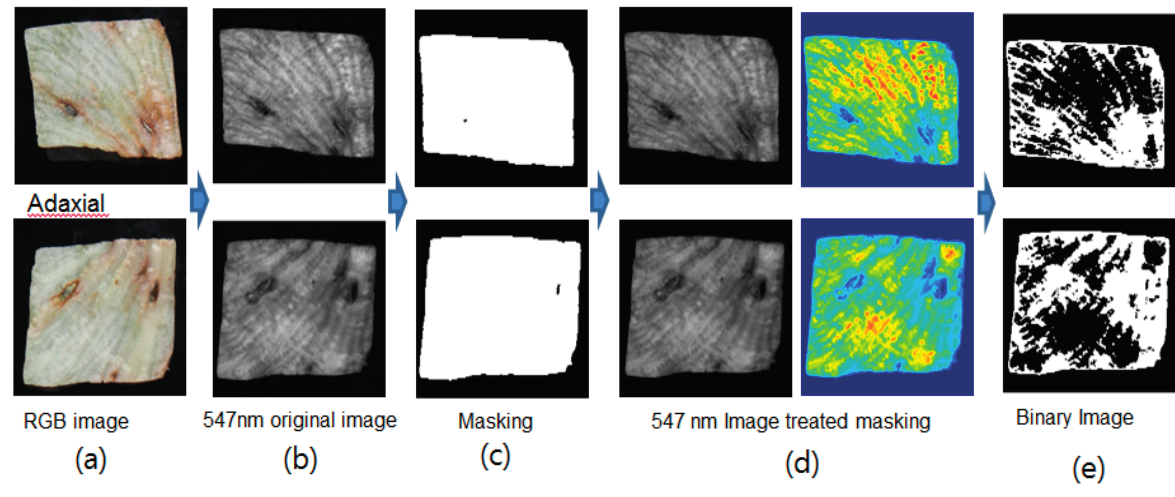
Figure 11. Illustration of the image processing sequence using a single waveband: ( a ) sample image; ( b ) grayscale I 547 image; ( c ) masking images obtained by applying a threshold of 0.07 reflectance to an I 547 image; ( d ) grayscale and color images of I 547 after masking; and ( e ) resulting detection images after the application of a 0.44